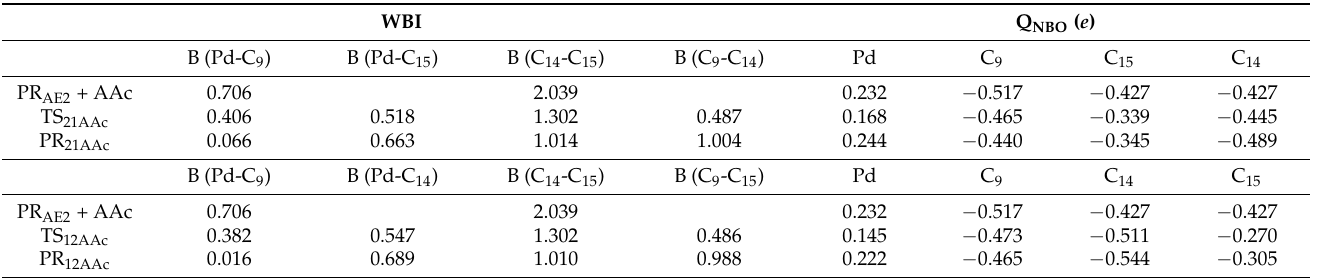
Table 5. The Wiberg bond indices (WBIs) and natural charges (Q NBO ) for some key bonds and atoms of the reaction pathway of the allyl acetate (AAc) insertion.